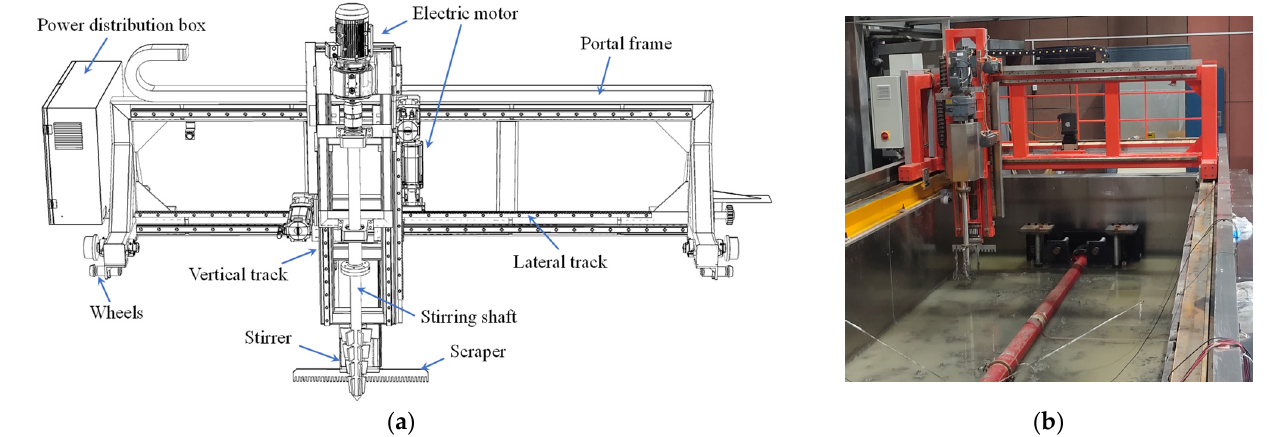
Figure 14. The soil stirring system: ( a ) schematic illustration and ( b ) constructed assembly.